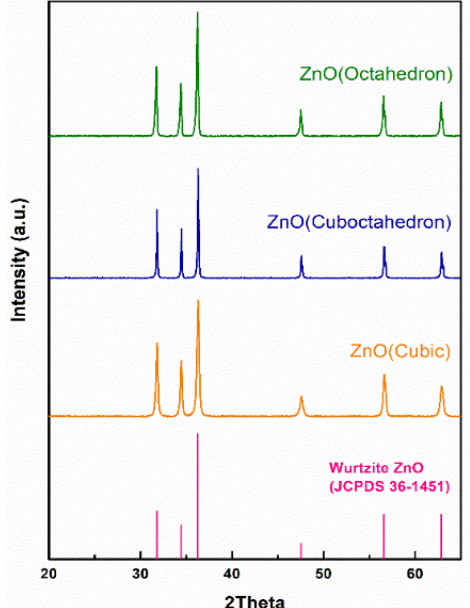
Figure 2. XRD patterns of the prepared ZnO that transformed from IRMOF-3 (cube, cuboctahedron, and octahedron shapes) compared with that of wurtzite ZnO (JCPDS 36-1451).